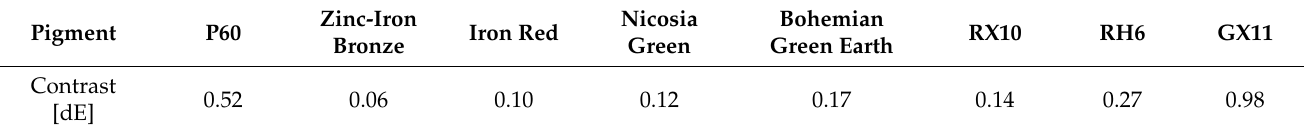
Table 2. Effects of pigments on